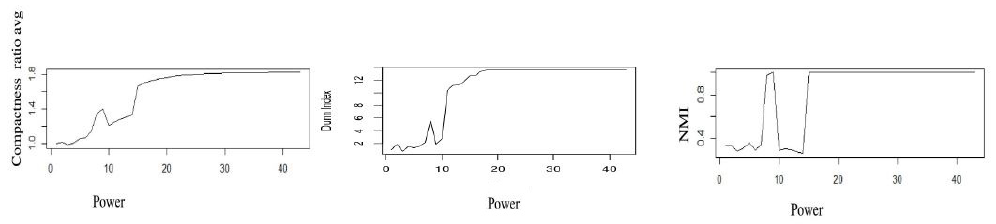
Figure 2. Compactness, Donn index and Normalized mutual information. Jain dataset.